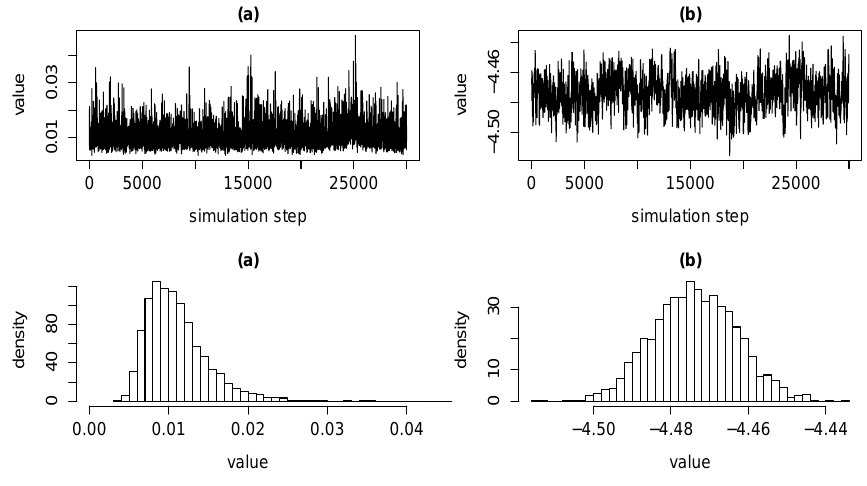
Figure 1. MCMC chains and corresponding density histograms for the variance of risk factor for deaths due to external causes of injury and poisoning σ 2 in subfigure ( a ) and for the death probability intercept 9 parameter of females aged 55 to 59 years α 2,f in subfigure ( b